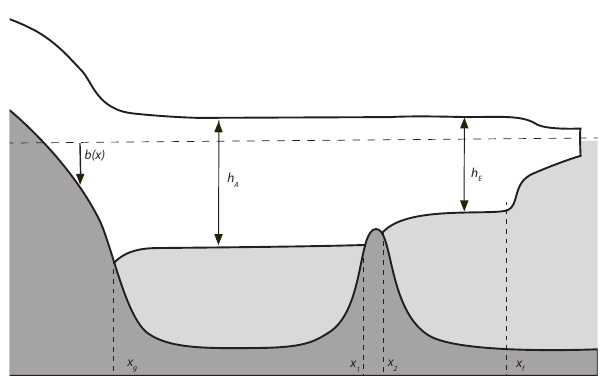
Figure 5. The Arctic Ocean ice-shelf geometry with grounding on the Lomonosov Ridge. The mean ice thicknesses in the Amerasian Basin (to the left of the ridge) and the Eurasian Basin (to the right of the ridge) are denoted h A and h E , respectively. The grounded-ice extent on the ridge is assumed to be long enough for an ice-sheet- like flow to develop. The upstream and downstream grounding-line positions on the ridge are denoted x 1 and x 2 , respectively. At x 1 , the ice-shelf thickness is h A and for notational convenience we in- troduce h 2 ≡ h(x 2 , t) .